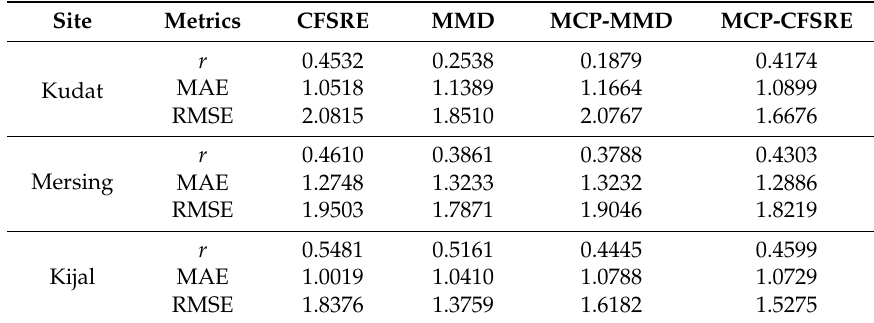
Table 2. The correlation coefficient and accuracy analysis of concurrent reanalysis and predicted data with measured wind mast